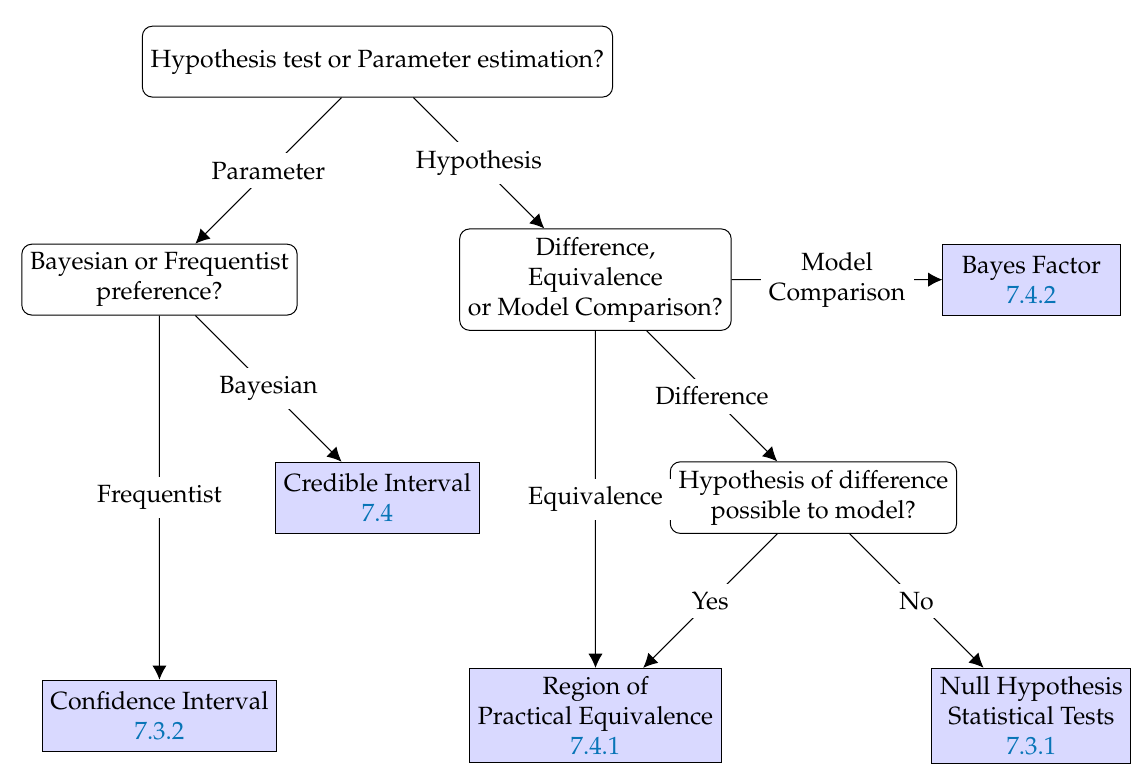
Figure 10. Flowchart outlining our method